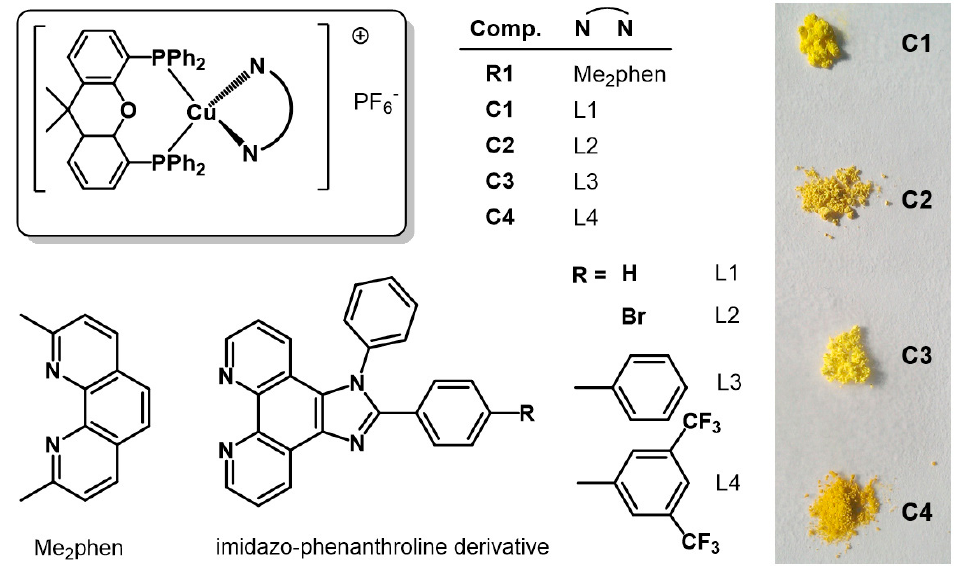
Figure 2. Left: Overview of the imidazo-phenanthroline type ligands L1 – L4 and their corresponding heteroleptic Cu(I) complexes C1 – C4 as well as the reference compound R1 investigated in this study. Right: Photograph of the complexes C1 – C4 showing their different colors in the solid state.